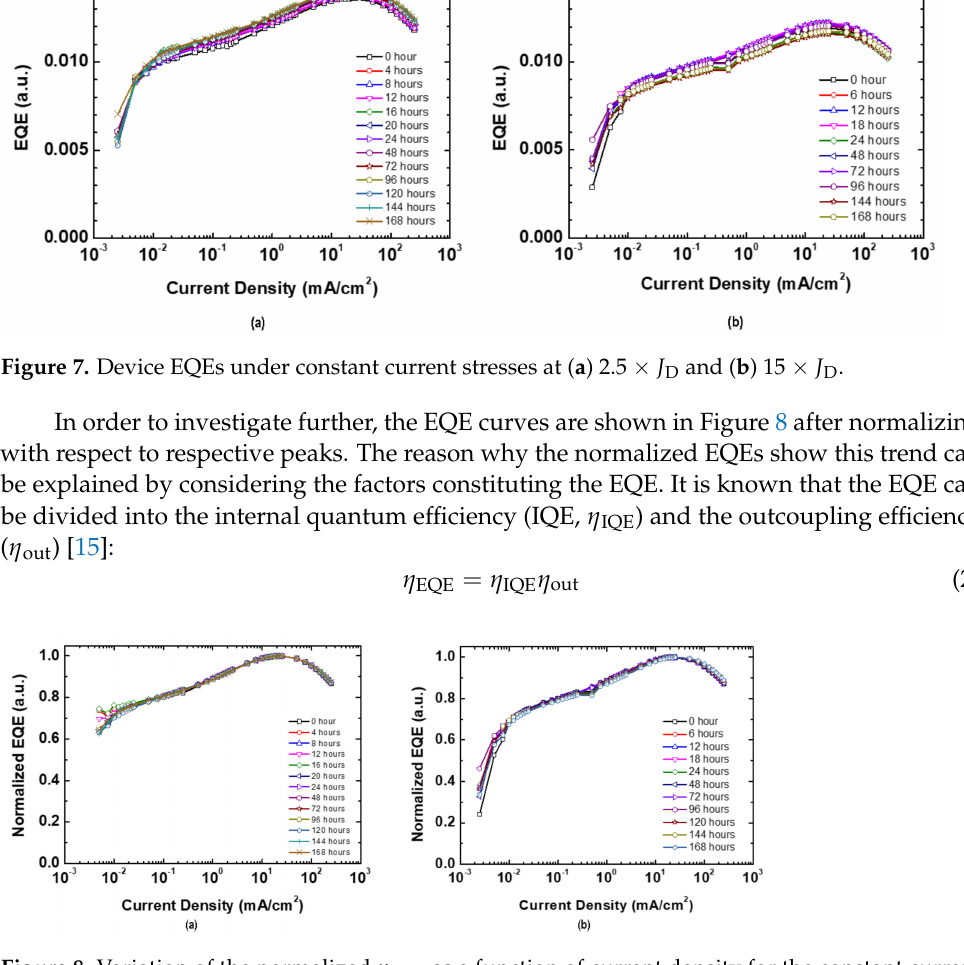
Figure 8. Variation of the normalized η EQE as a function of current density for the constant current stresses at ( a ) 2.5 × J D and ( b ) 15 × J D